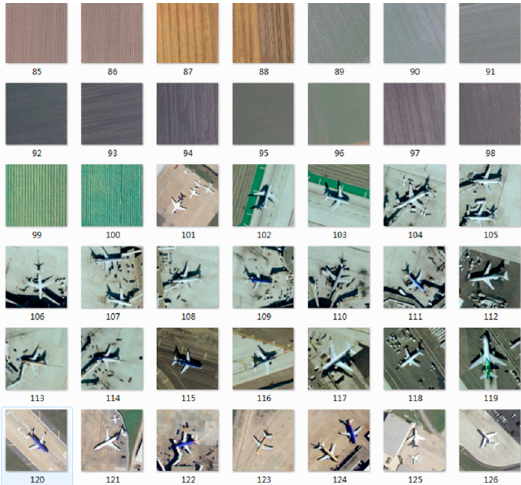
Figure 4. Parts of images of UCM Dataset.